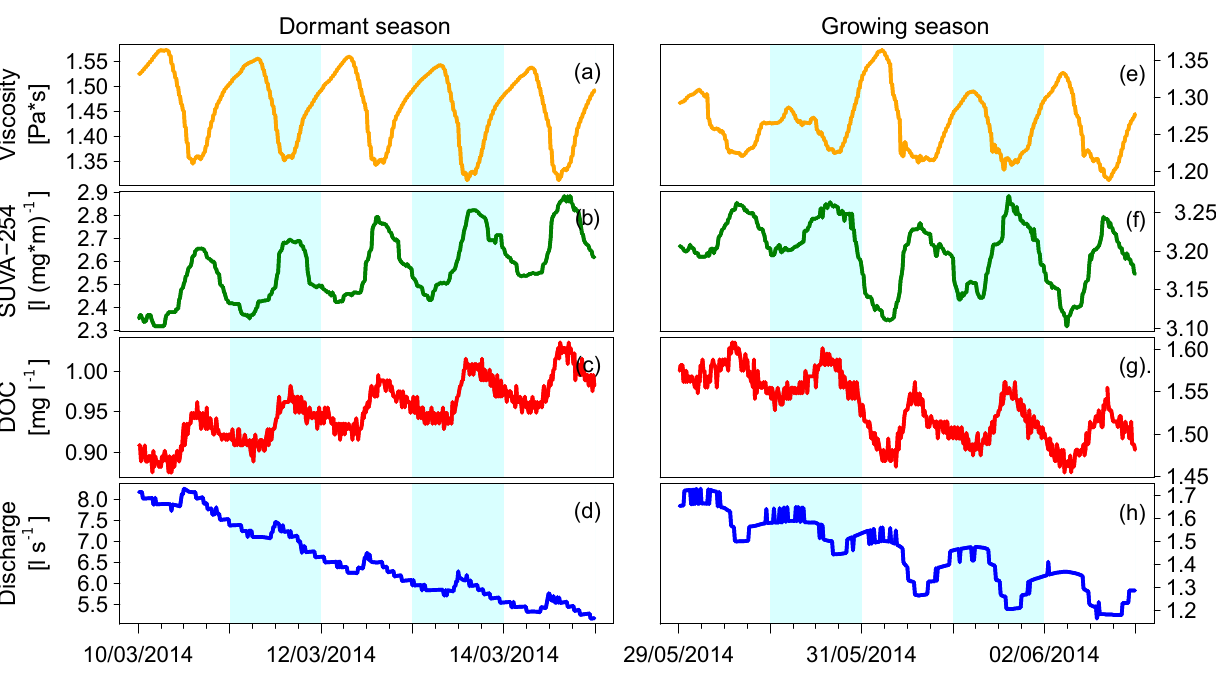
Figure 2. Diel fluctuations in the viscosity of saturated riparian water, SUVA-254, DOC and discharge during a representative rainless period in the dormant season and the growing